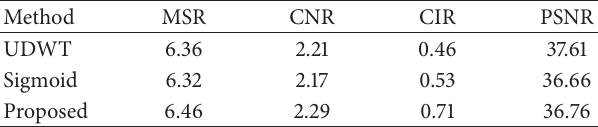
Table 4: Comparison of image processing methods in terms of 4 quantitative quality metrics for chest